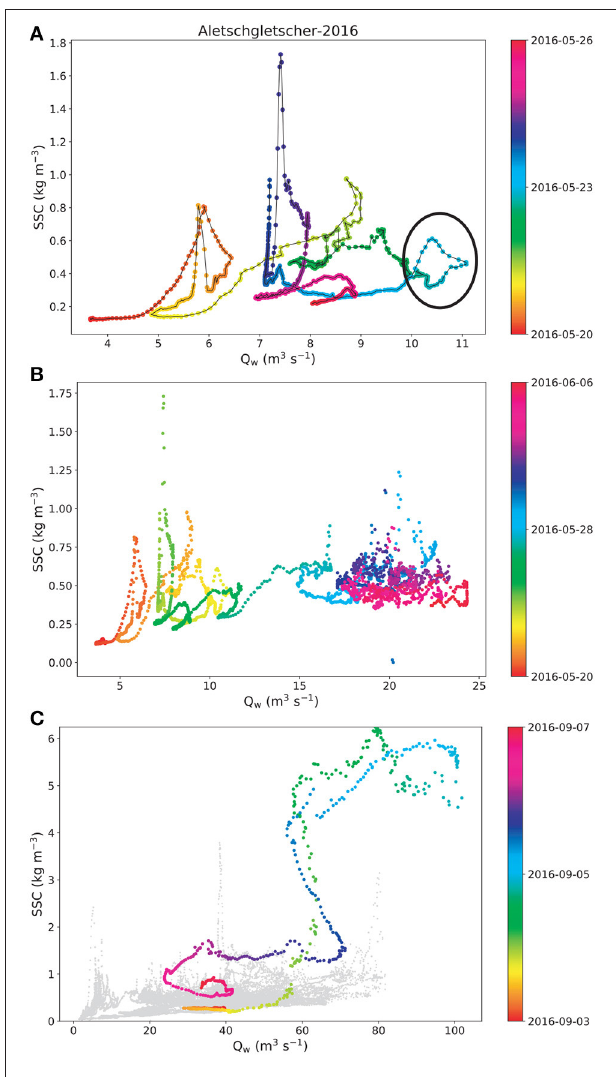
FIGURE 8 | Relationship between water discharge (Q w ) and suspended sediment concentration (SSC) for notable events in the Aletschgletscher catchment. (A) Strong hysteresis between discharge and sediment concentration in early season. Counter-clockwise loop discussed is marked. (B) Transition from strong hysteresis between discharge and sediment concentration to chaotic relationship. (C) High-precipitation event in the Aletschgletscher catchment in colored dots, with season-long relationship in gray